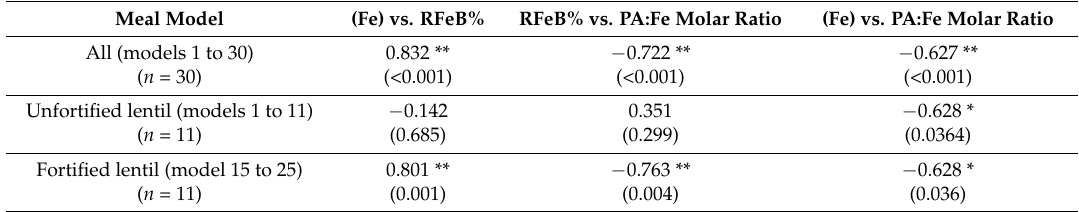
Table 1. Pearson correlation coefficients for iron (Fe) concentration vs. relative Fe